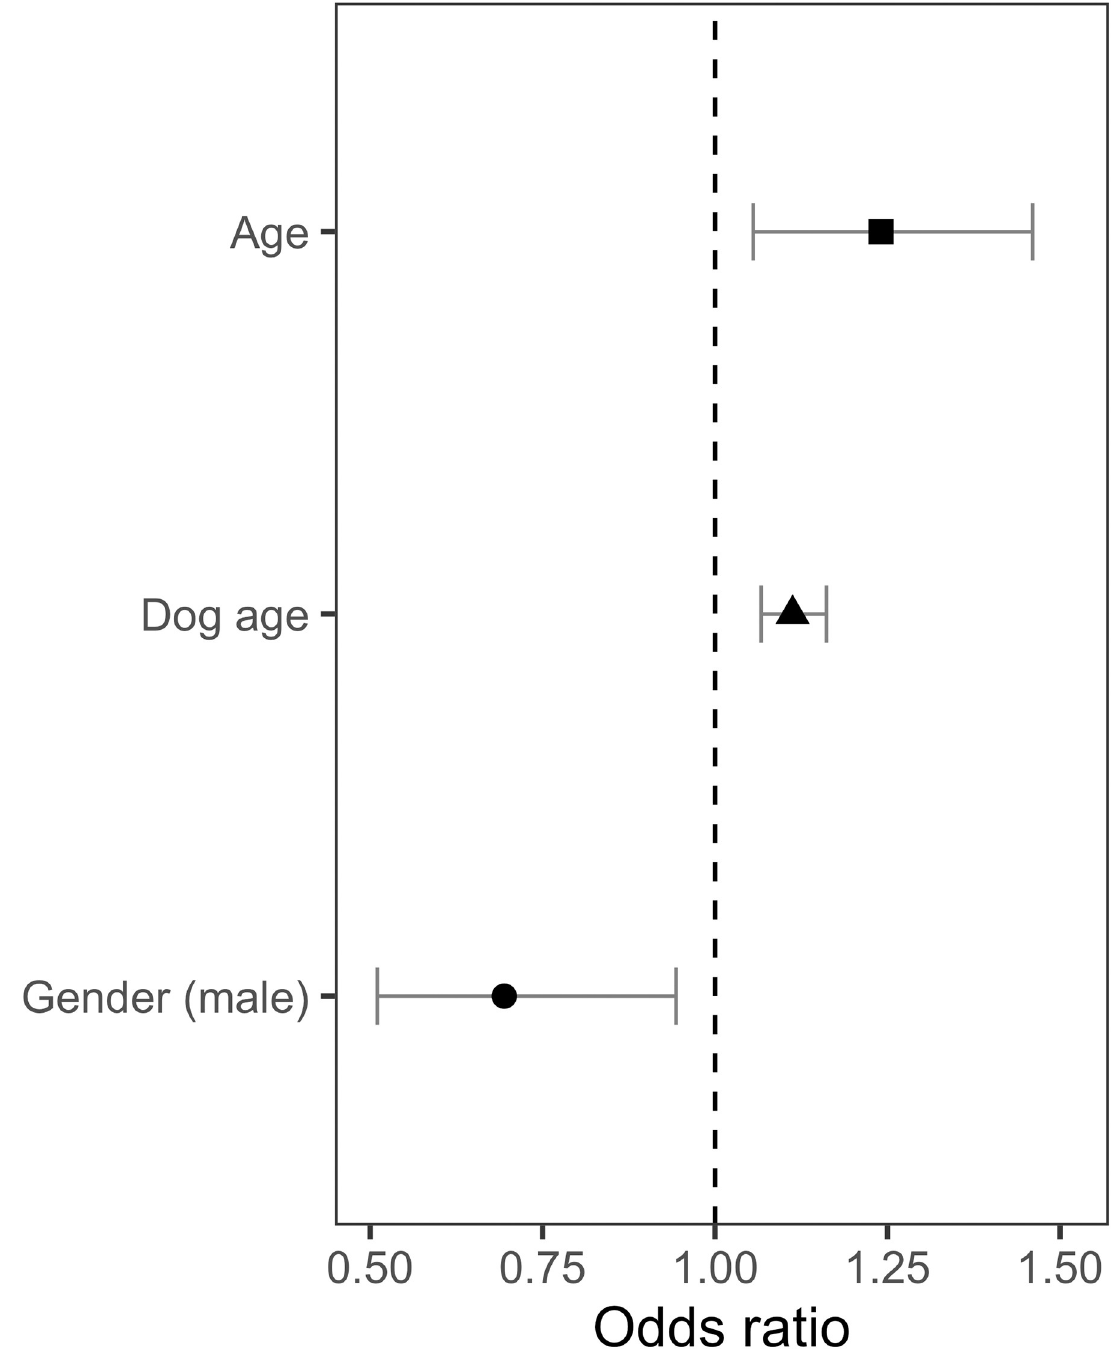
Fig 1. Statistically significant owner and dog parameters on the professional help outcome. Professional help outcome odds predicted by statistically significant predictor variables: owner age (P = .009), dog age (P < .001), and male owners (P = .019), calculated by the logistic regression